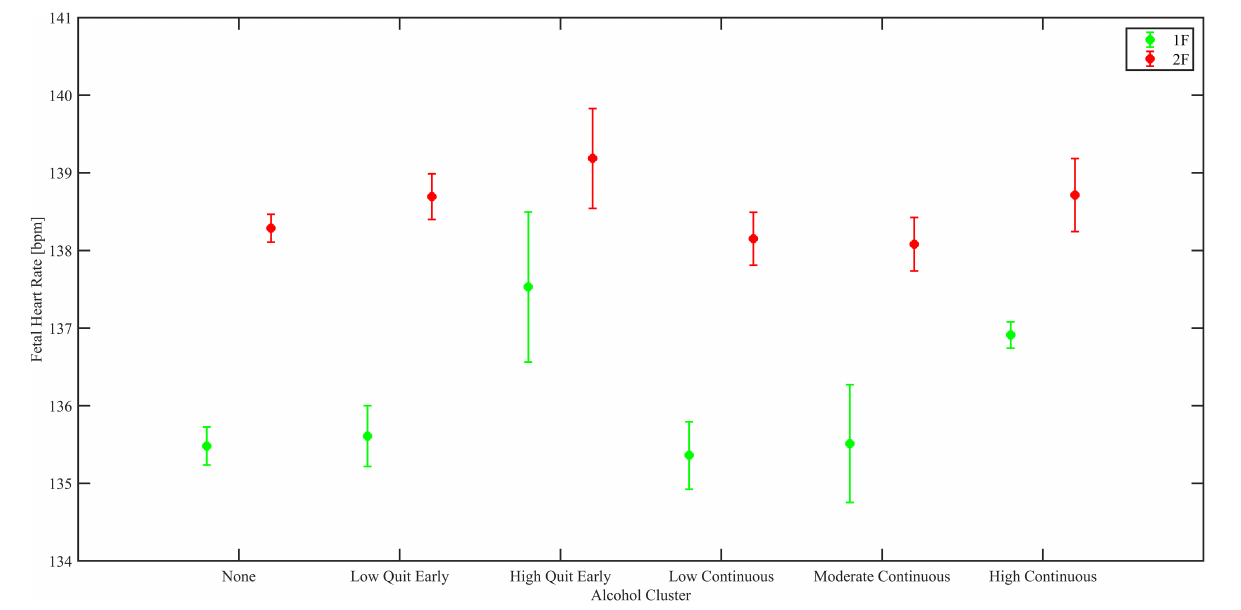
FIGURE 3 | Estimated marginal means from linear regression models of mean fetal HR, shown for the SA population by fetal behavioral sleep state (green 1F and red